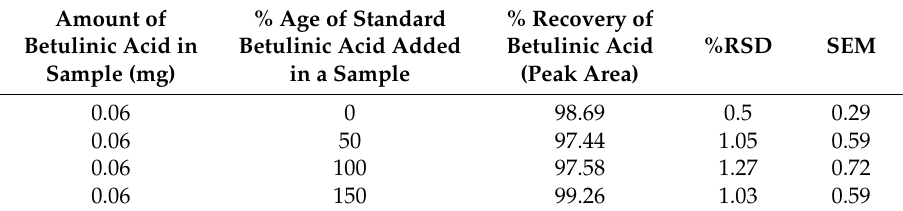
Table 3. Accuracy Analysis ( n = 3).